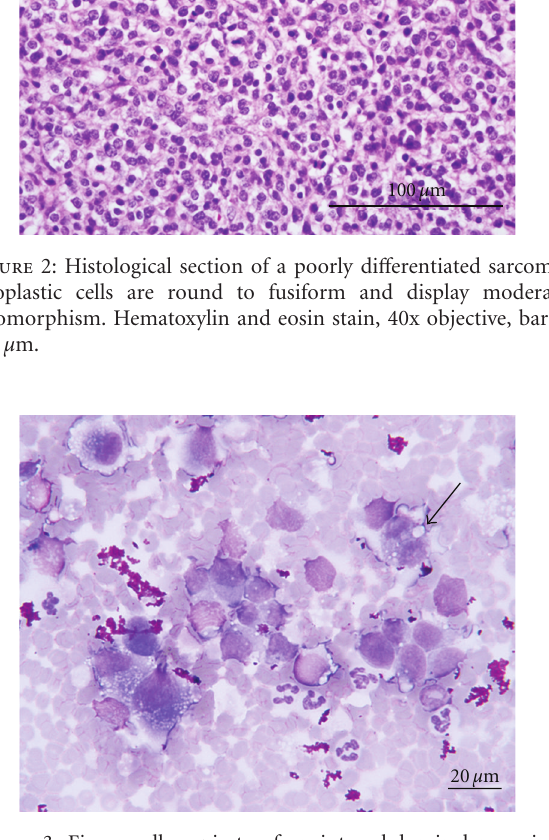
Figure 3: Fine-needle aspirate of an intra-abdominal mass in a young dog. Many individualized, large, round to fusiform cells that often contain vacuoles and display moderate anisocytosis and anisokaryosis are present. Note the mitotic figure (arrow). The primary di ff erential diagnosis was neoplasia (histiocytic sarcoma, other sarcomas, or atypical lymphoma). Wright’s—Giemsa stain, 50x objective, bar = 20 µ m.